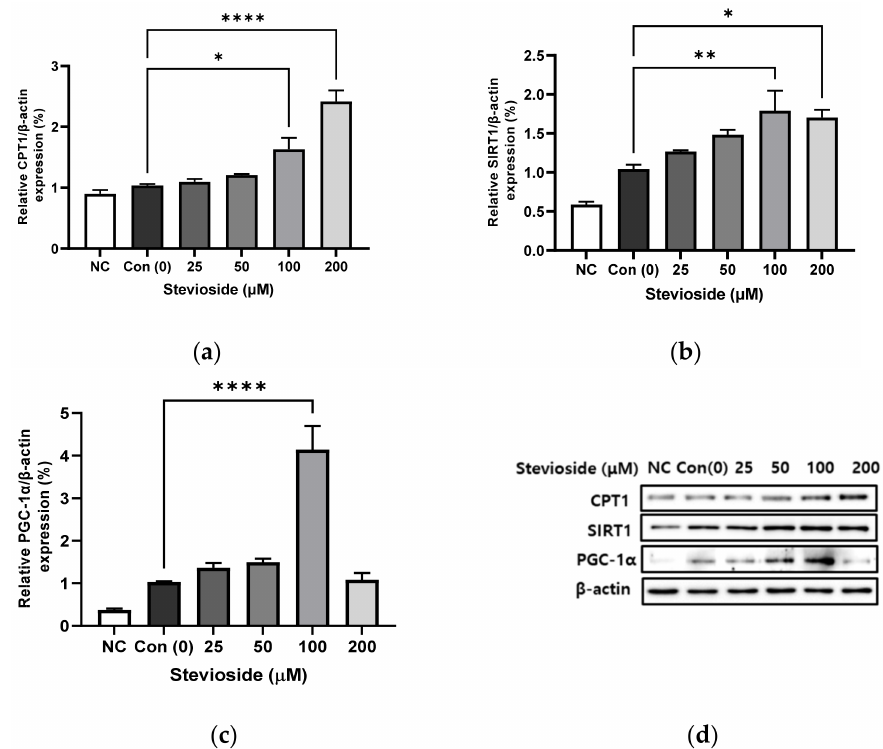
Figure 3. The effect of stevioside on the expression in fatty acid oxidation-related proteins. Relative protein expressions of ( a ) carnitine palmitoyltransferase -1 (CPT-1), ( b ) silent mating type information regulation 2 homolog 1 (SIRT1), and ( c ) peroxisome proliferator-activated receptor gamma coactivator 1 alpha (PGC-1 α ) were normalized with β -actin. ( d ) Immunoblot analysis of the expression in fatty acid oxidation related protein in 3T3-L1 cells. All data are presented as mean ± SD, and tests were performed in three independent experiments. * p < 0.05, ** p < 0.01 and **** p < 0.0001. Negative control (NC) was not treated with an adipocyte differentiation cocktail.